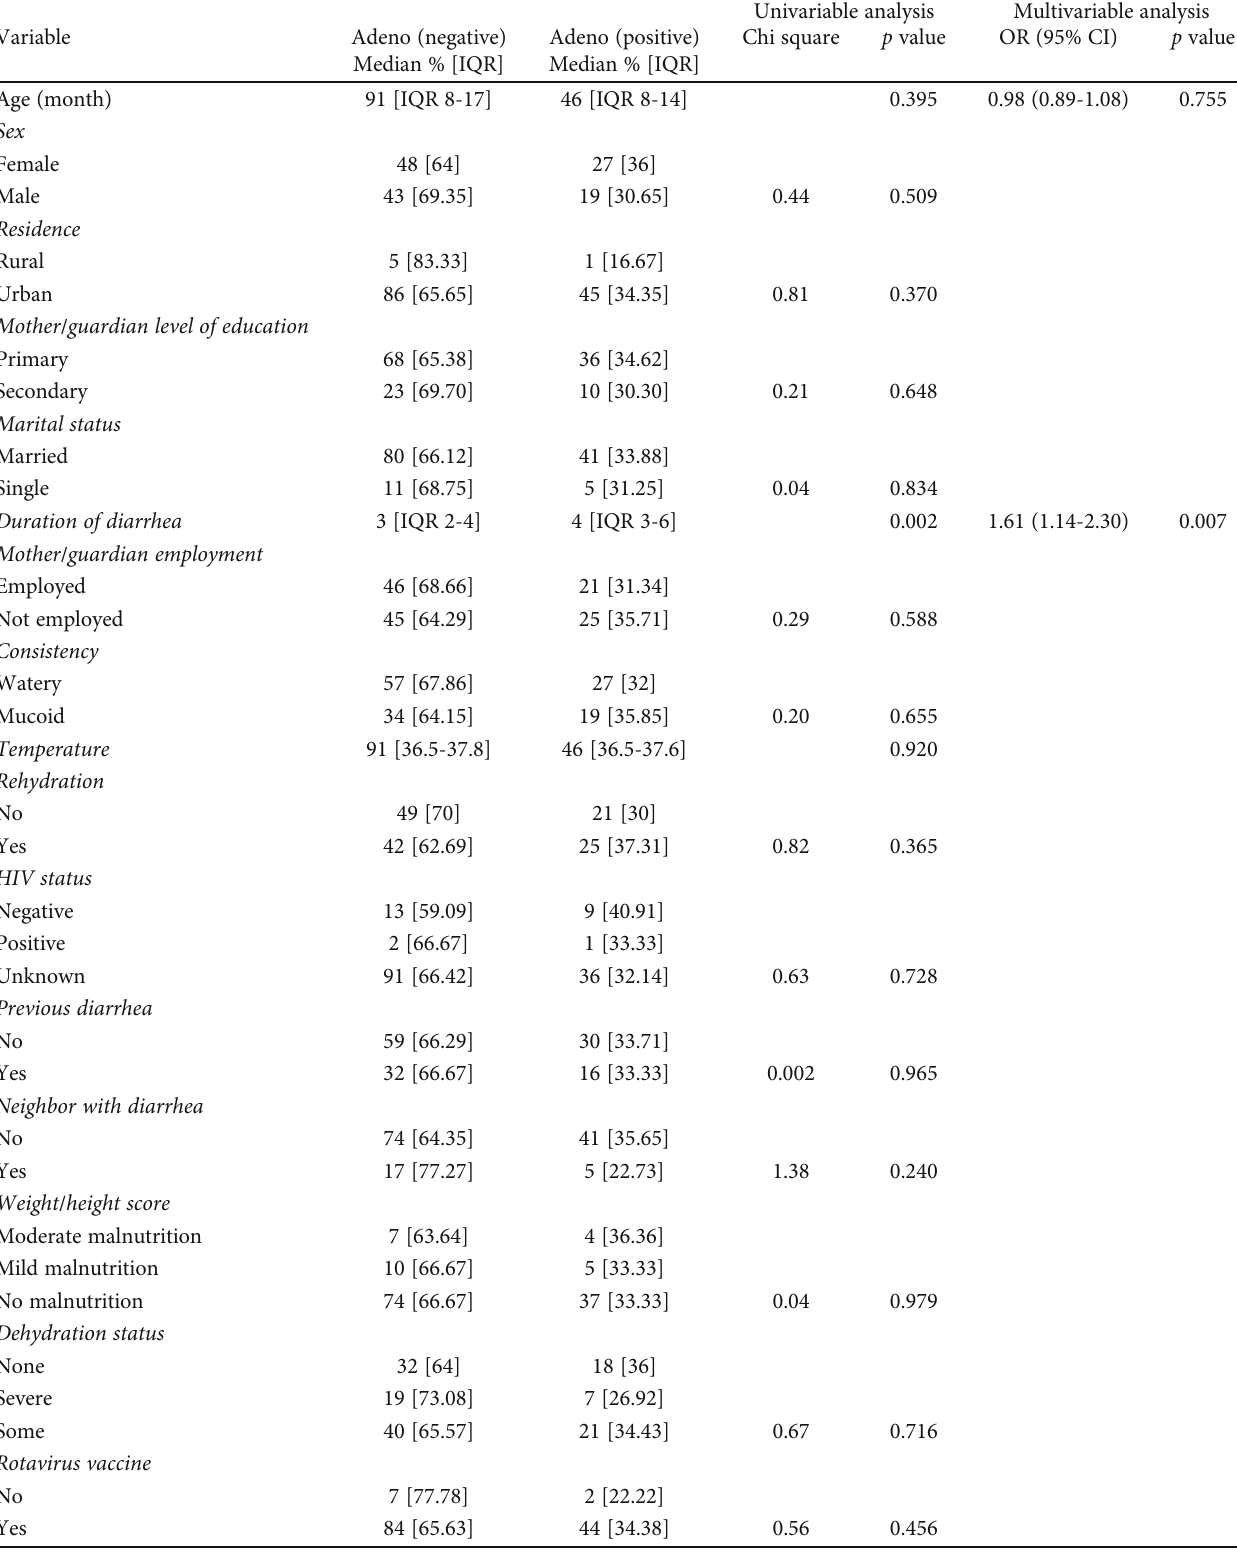
Table 2: Factors associated with adenovirus infection among children with diarrhea in Mwanza